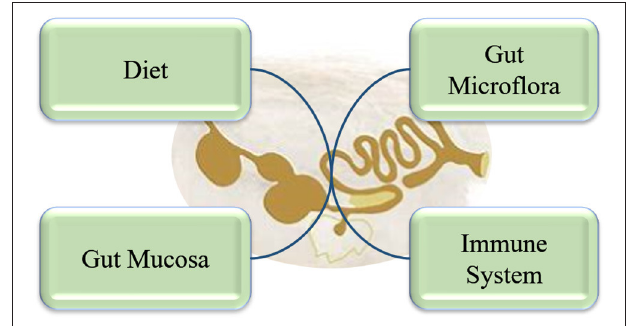
FIGURE 1 | Components of gut health in a holistic